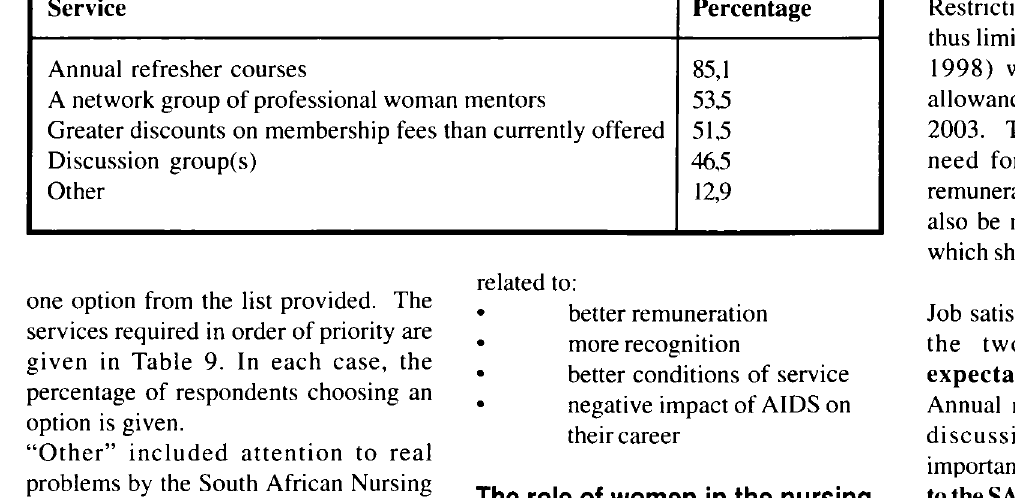
Table 9 Services required from the South African Nursing Council